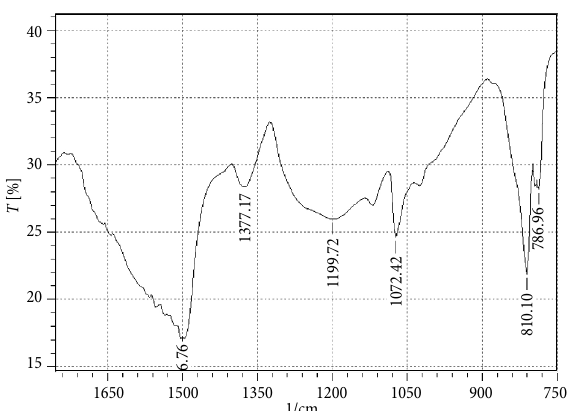
Fig. 2. IR-spectrum of the MMSCO filler in the range of wave numbers ν = 1650÷750 cm –1